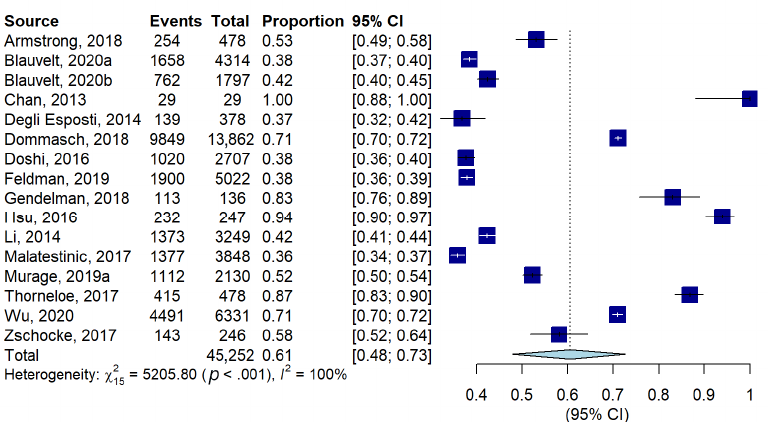
Figure 2. Forest plot of proportions, and their 95% confidence intervals, of adherent patients.